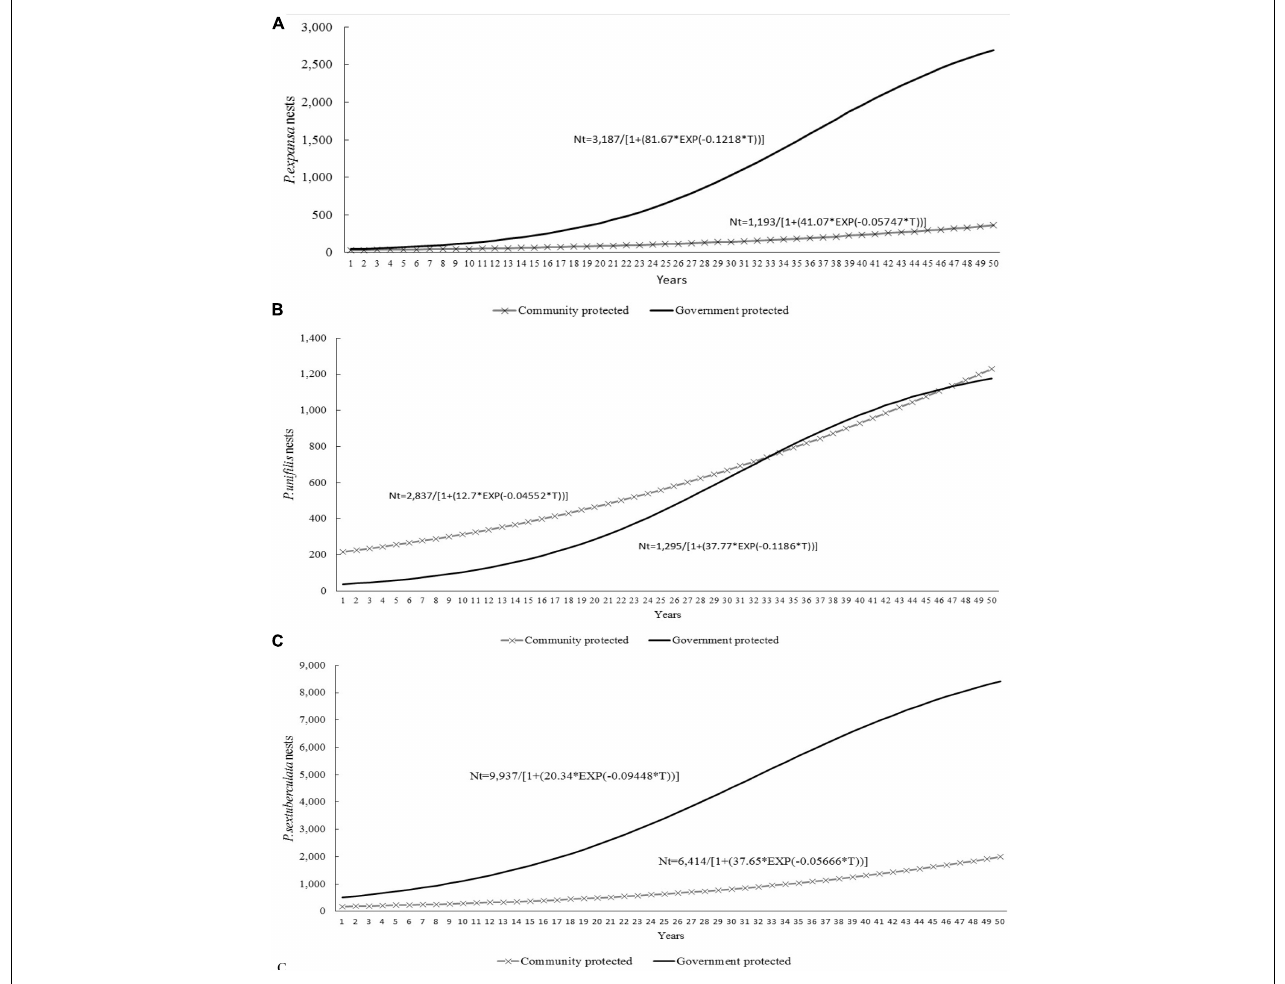
FIGURE 12 | Logistic growth curves of the number of nests/reproductive females in the Amazonas state and the northwestern section of the Pará state, Brazil: (A) P. expansa ; (B) P. unifilis ; (C) P. sextuberculata